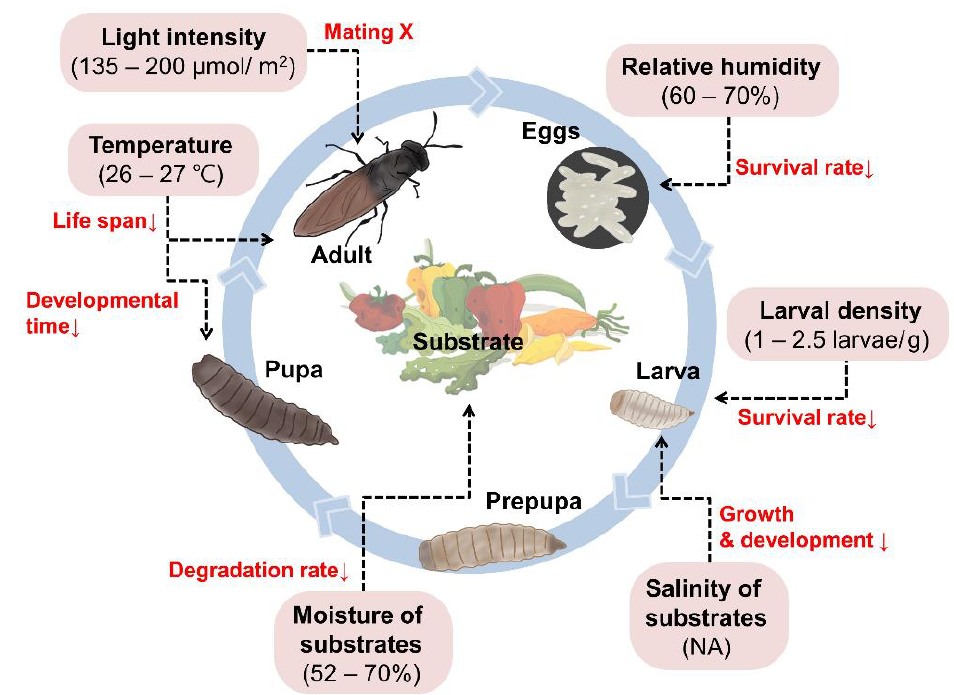
Figure 2. Factors that directly affect black soldier fly ( Hermetia illucens ) larvae (BSFL) growth. Optimal ranges are indicated below the factors. The consequences that follow when each factor is not properly controlled are shown in red. (i) Relative humidity: survival rate decreases when relative humidity is lower than the optimal range [25,30]; (ii) larval density: indicates the ratio between substrate weight (g) and number of larvae, and survival rate decreases when larval density is higher than the optimal range [14]; (iii) light intensity: mating does not occur depending on the light source [25,31]; (iv) temperature: adult life span and pupal development time decrease when temperature is higher than the optimal range [25,26]; (v) salinity of substrate: growth rate and development of larvae decrease when salinity of substrate increases [14]; (vi) moisture of substrates: degradation rate decreases when moisture is higher than the optimal range [25,32].